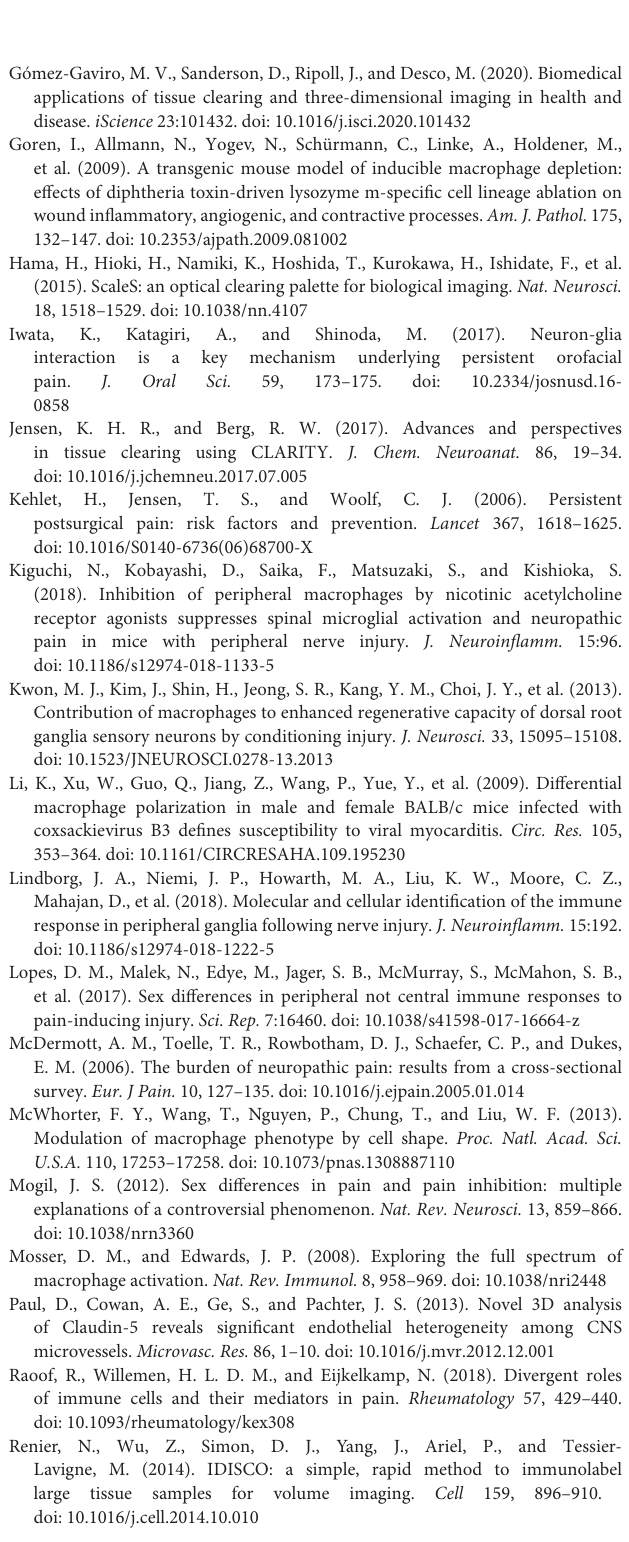
Supplementary Figure 8 | 3-Dimensional video render of a cleared Female SNI Contralateral DRG. Visualized cells are LysM tdT + macrophages infiltrating into the